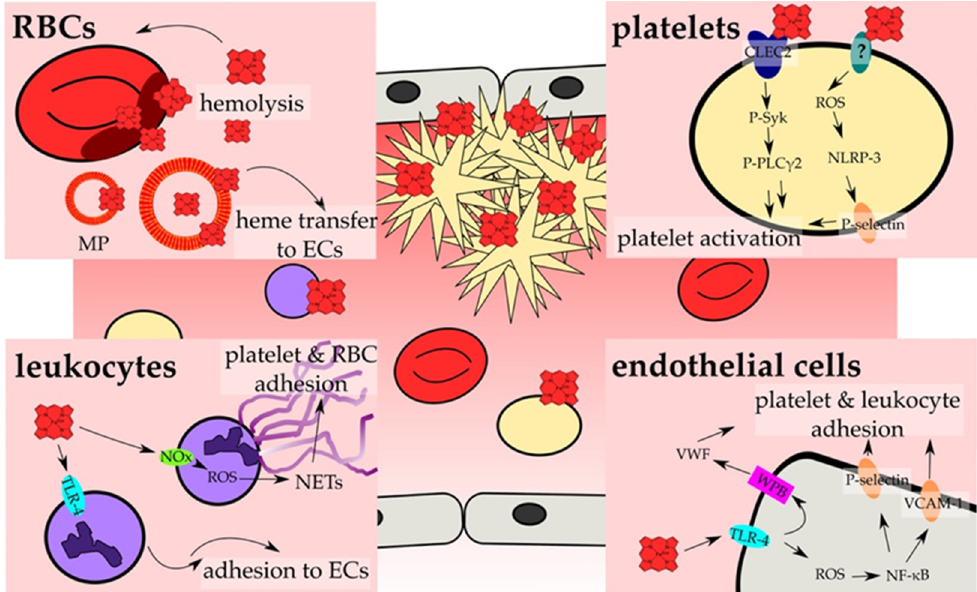
Figure 3. Heme activates cellular components of hemostasis. The main investigated pathways and consequences that result in the activation of cellular components of hemostasis and, thus, prothrombotic reactions by heme are depicted. On cellular level, hemostasis results from an interplay of RBCs (red, Section 4.3), platelets (yellow; Section 4.1), leukocytes (violet; Section 4.4) and endothelial cells (ECs, grey; Section 4.2). RBCs contribute to heme-induced hemostasis through the release of heme upon hemolysis, which can be further strengthened by heme itself (Section 4.3). Moreover, erythrocyte membrane particles (MP) incorporate and accumulate heme within the membrane, and allow for the transfer of heme to ECs (Section 4.2). These, in turn, become activated by heme in a TLR-4 -dependent manner (turquoise), which can lead either to the secretion of the contents of Weibel Palade bodies (WPBs; pink) (Section 4.2), among them VWF, or to ROS generation that triggers the increase of surface expression of adhesion proteins, such as P-selectin and VCAM-1 (orange) (Section 4.2). The exposure of those adhesion molecules as well as the secretion of VWF leads to the adhesion of platelets and leukocytes onto the endothelium. In contrast, activation of TLR-4 in leukocytes promotes the rolling and adhesion to ECs (Section 4.4). In addition, heme-induced NADPH oxidase (NOx; green)-dependent ROS generation in neutrophils can lead to NET formation, forming the scaffold for the adhesion of platelets and RBCs (Section 4.4). Finally, heme can also directly activate platelets. Two main mechanisms have been proposed. On the one hand, heme binding to CLEC2 was shown, leading to the phosphorylation of Syk (P-Syk) and PLC γ 2 (P-PLC γ 2) and eventually to the activation of platelets (Section 4.1). On the other hand, a ROS-dependent activation of the inflammasome via NLRP-3 has been demonstrated, which culminates in the expression of for example P-selectin, which again allows for the adhesion and activation of platelets (Section 4.1). Furthermore, the induction of ferroptosis (platelets) as well as apoptosis and necroptosis (endothelial cells) by heme has been demonstrated, which further might support the activation of endothelial cells and platelets (not shown; Sections 4.1 and